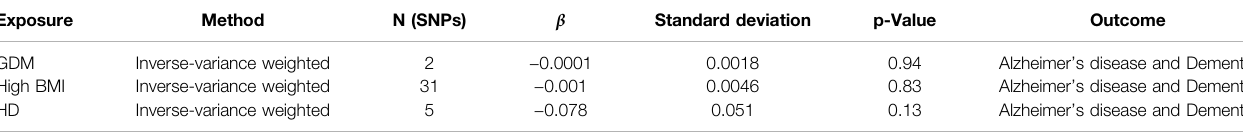
TABLE 2 | | Results of MVMR analysis regarding the overall causality between GDM, high BMI, HD and maternal AD/dementia.